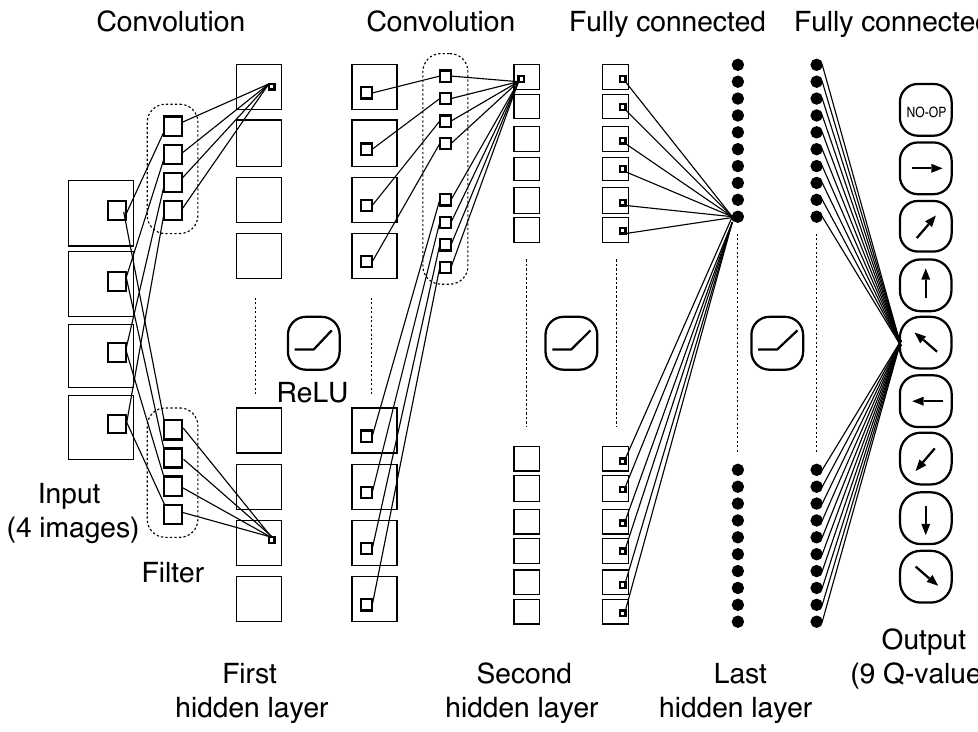
Figure 3: Structure of deep Q